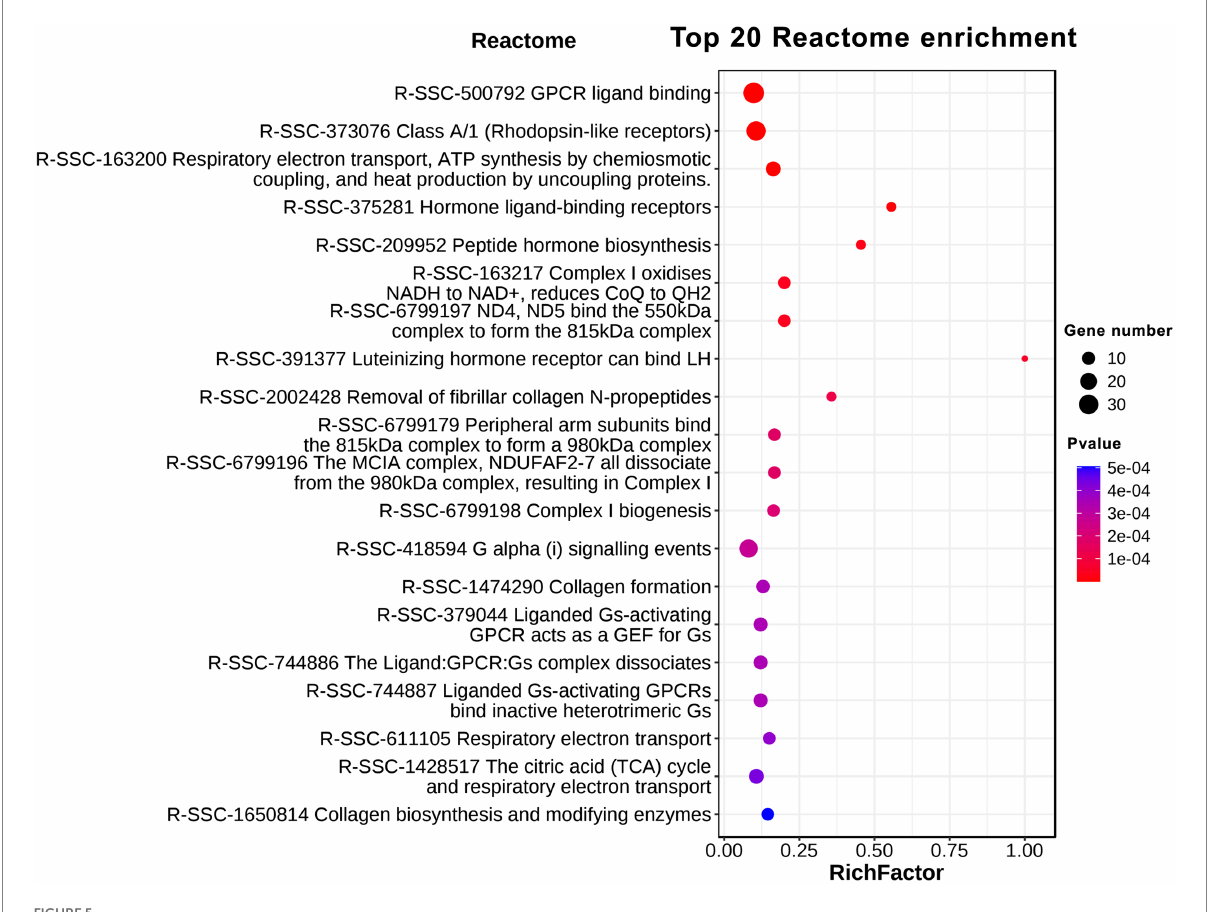
FIGURE 5 Reactome enrichment analysis of differentially expressed protein-coding